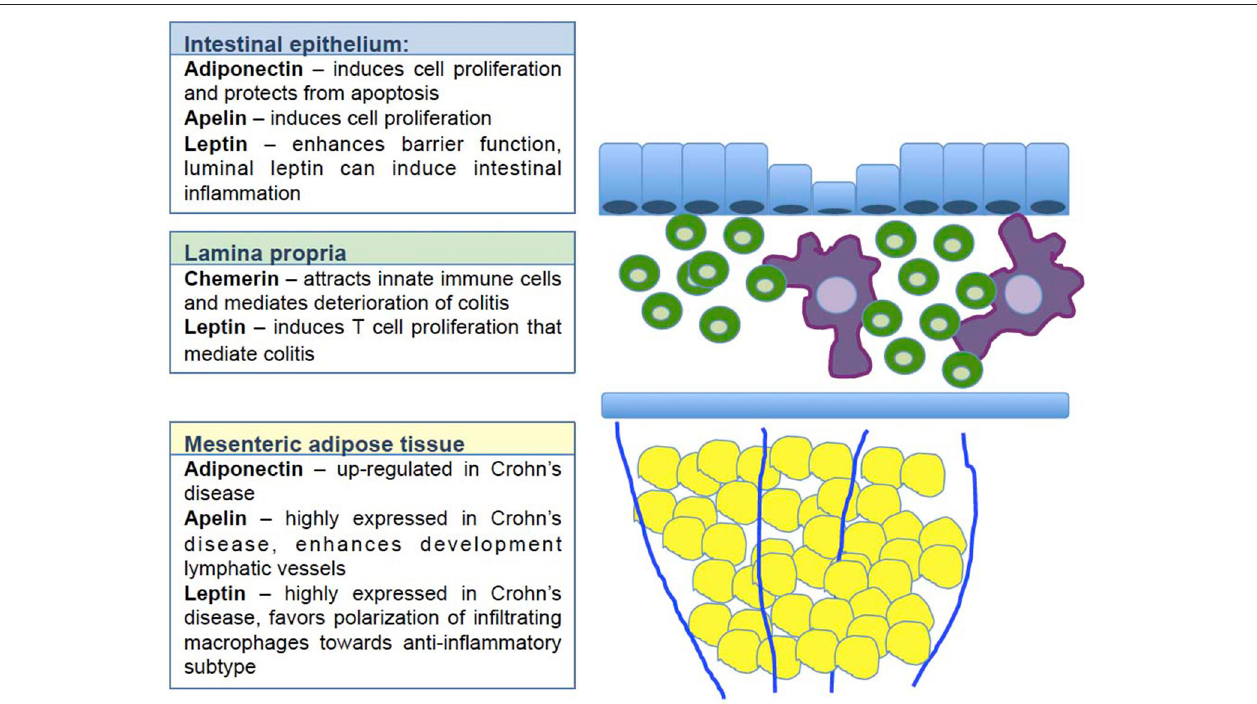
FIGURE 1 | Regulatory effect of selected adipokines on intestinal homeostasis. The figure illustrates at which layer of the intestinal wall the selected adipokines exert their respective regulatory function. Blue indicates the intestinal epithelial layer. Adiponectin, apelin and leptin have been shown to enhance cell proliferation and enhance barrier function. The majority of these data derive from in vitro data, thus it remains open how these adipokines contribute to the complex crosstalk between epithelial cells and immune cells in vivo . Green indicates the lamina propria with all cell populations included. Chemerin has been shown here to attract innate immune cells resulting in a deterioration of colitis. Leptin induces T cell proliferation thus enhancing inflammation. Yellow indicates the mesenteric fat tissue. Adiponectin, apelin and leptin are all up-regulated in this compartment. Apelin enhances the function of the lymphatic vessels, that are known to be dysfunctional in Crohn’s disease. Leptin strongly influences the polarization of infiltrating monocytes toward rather anti-inflammatory